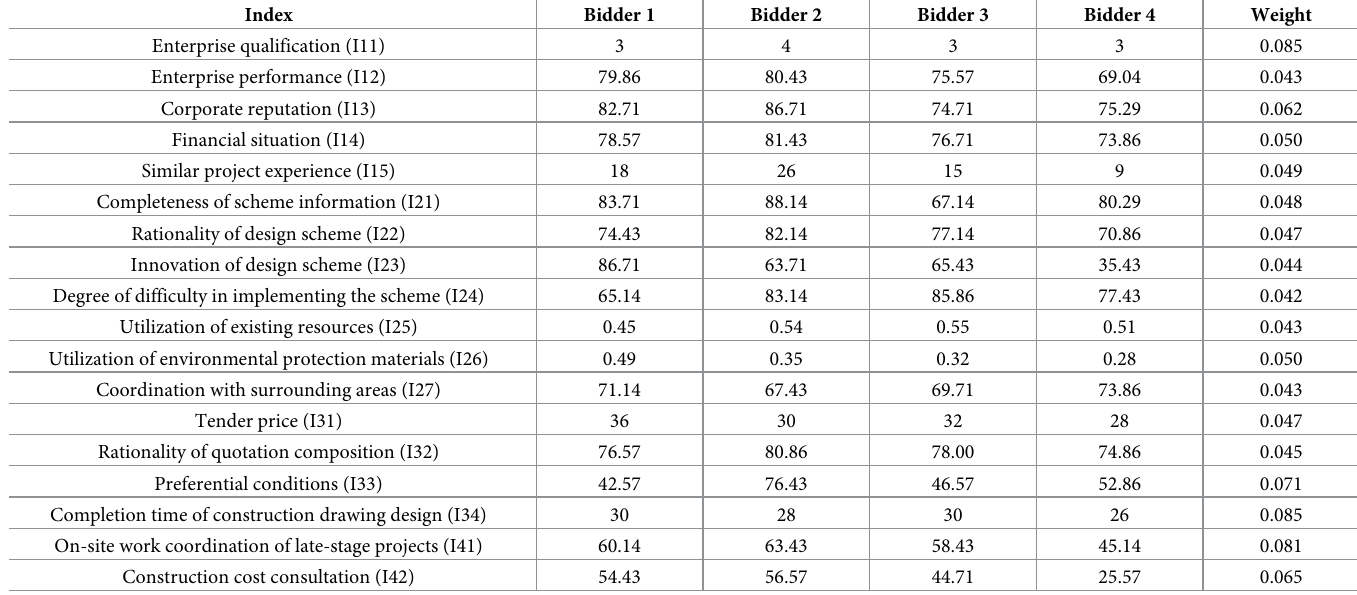
Table 2. Specific score values and weight values of the bid evaluation